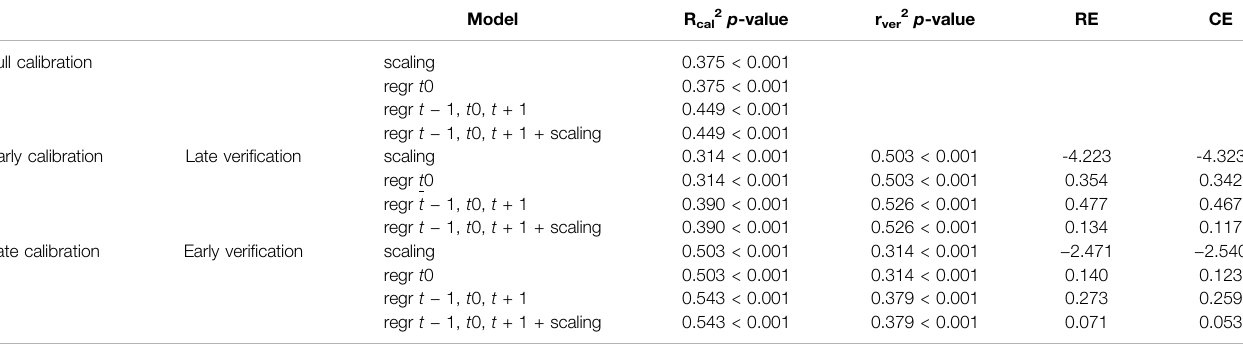
TABLE 2| Calibration and veri fi cation statistics over the pre-industrial period. The BI (minimum blue channel light intensity) record transformed into atemperature scale over the full, early, and late calibration periods (117 – 1811 CE, 117 – 964 CE, and 965 – 1811 CE, respectively) and the obtained temperature reconstructions veri fi ed over the late and early veri fi cation periods (965 – 1811 CE and 117 – 964 CE, respectively). The calibration/veri fi cation statistics include the coef fi cient of determination (R cal2 ) and varianceexplained(r ver2 ),givenwiththeirMonteCarlo – based p -values,andthereductionoferror(RE)andthecoef fi cientofef fi ciency(CE).Regressionmodels(regr)withone ( t 0; concurrent of dependent value) or multiple independent variables ( t − 1, t 0, t + 1; predating, concurrent, and lagging the dependent value) are included. For regression-based reconstructions, the RE and CE statistics are positive for both sub-periods, indicating real skill in the